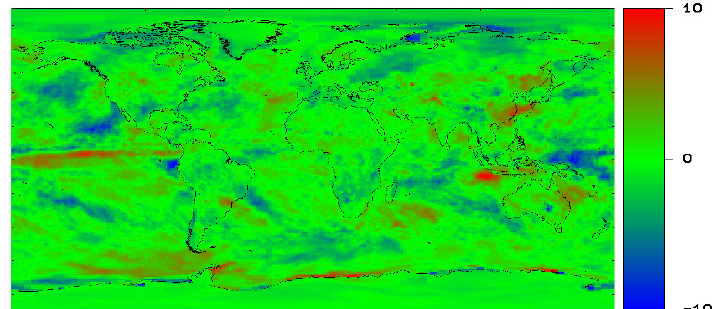
Figure 4. All-sky RSR for period 08/2009–07/2018 minus 08/2000–07/2009. The scale is in W/m 2 .